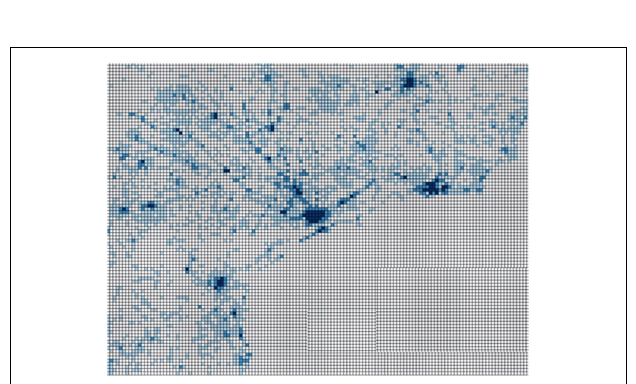
FIGURE 8 | Road length (in km) for each 9 × 9km grid cell.